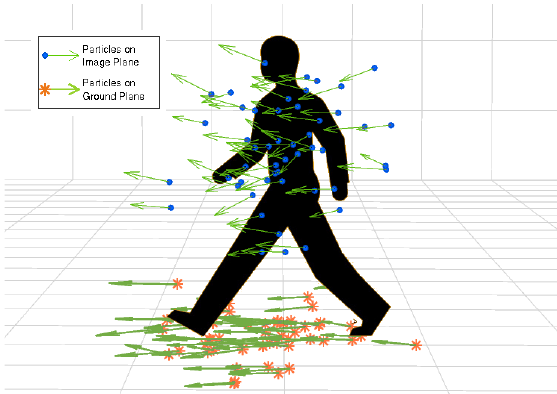
Figure 3. Graphical illustration of the layout of our 2D–3D particle filter tracker. State variables on the image plane are modeled by particles (blue) which are independent from the particles that model the ground plane state variables